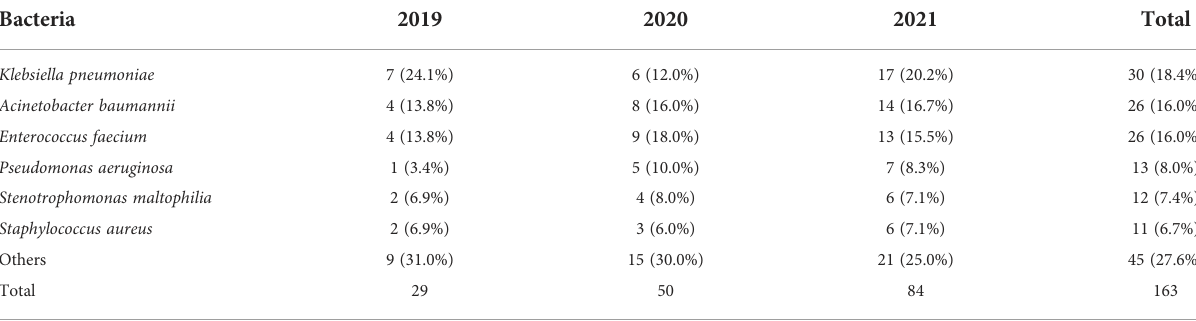
TABLE 3 Composition of bacteria